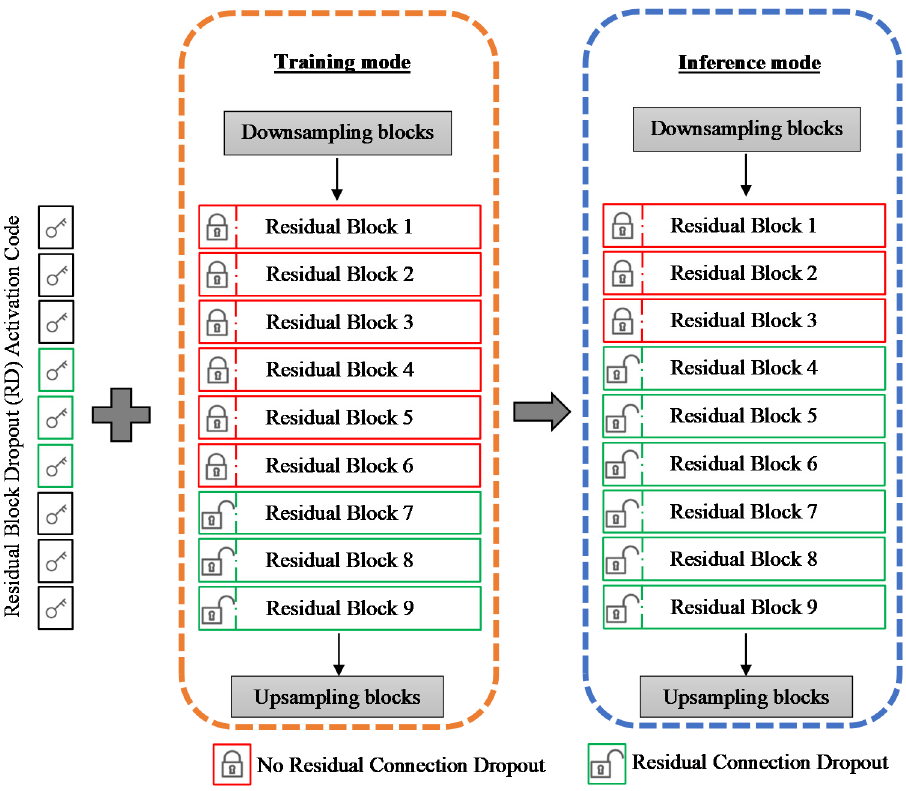
Figure 2. Image transformation network incorporated with the residual dropout mechanism in the train- ing mode and the inference mode. The RD-activation code illustrates the reconfiguring of the residual dropout at the inference mode to amplify the latent space stochasticity without any model retraining.